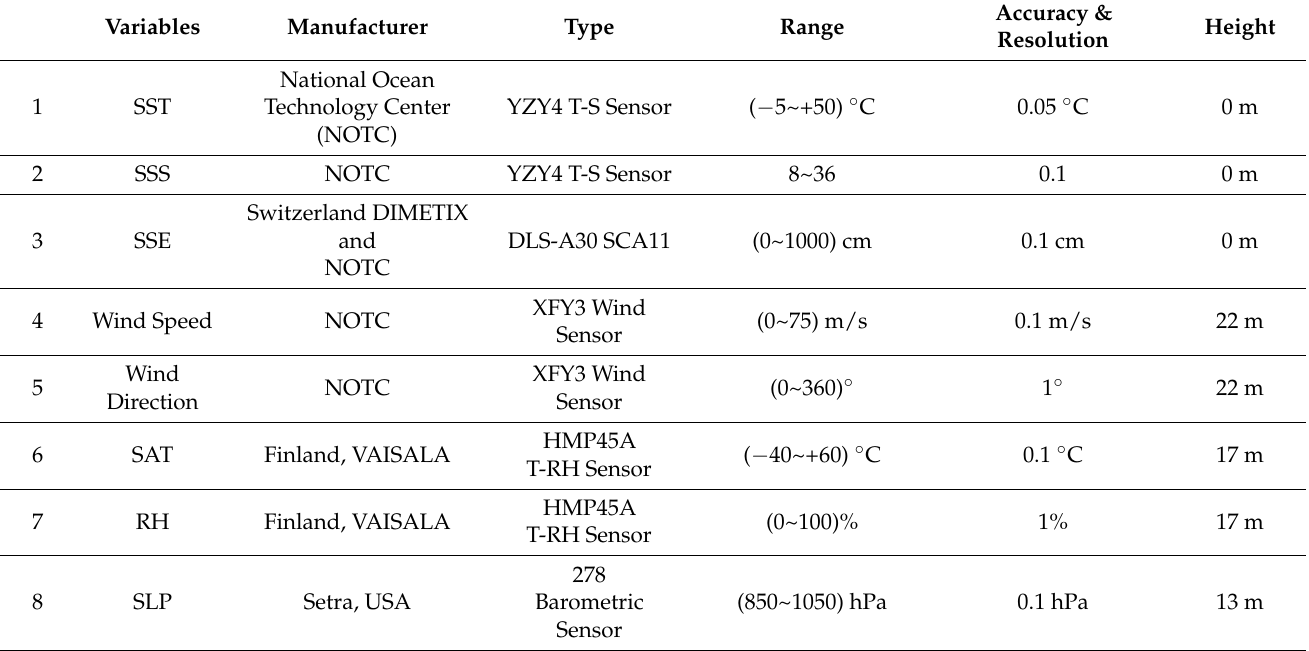
Table 1. Information on the observed variables and associated instruments on the